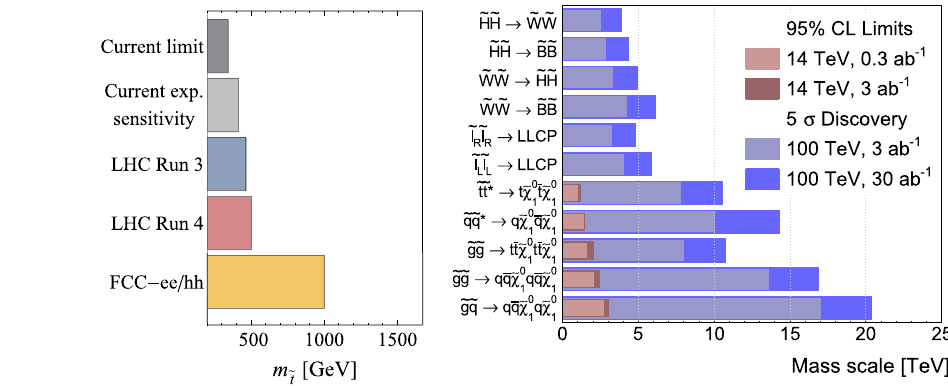
Fig. 9.1 Left: projected 2 σ indirect reach solely from Higgs coupling constraints on stops from FCC-ee and FCC-hh [278]. Right: projected direct FCC-hh 2 σ and 5 σ discovery reach for supersymmetric Higgsinos, Winos, sleptons, stops, squarks, and gluinos (see Ref. [279] for details). HL-LHC projections are only shown for coloured sparticles and projections for Higgsinos and Winos are currently under